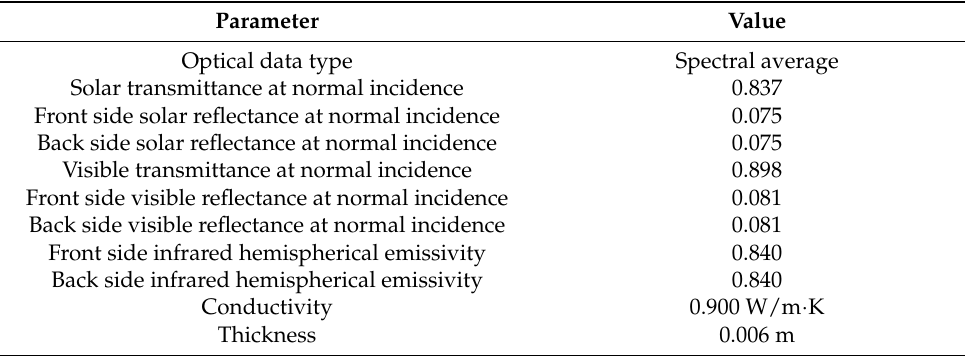
Figure 2. 3D view of a building model. Table 2. Window input variables.